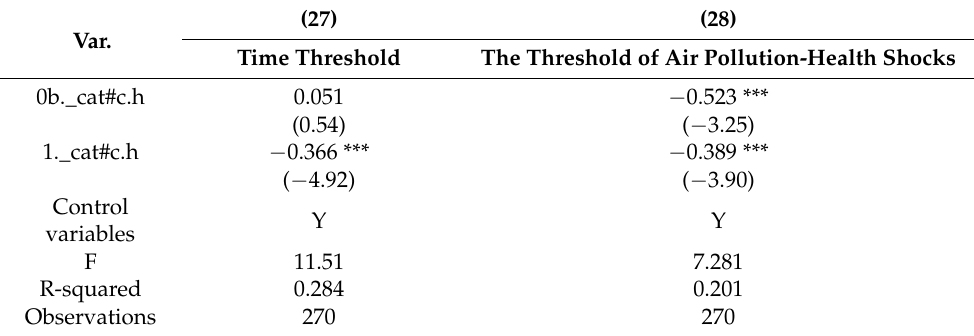
Table 9. The impact effect estimation of threshold